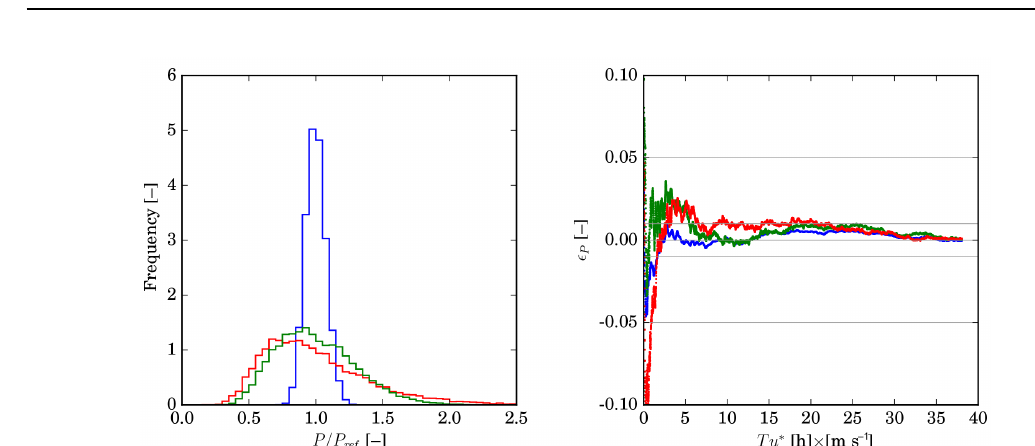
Figure 2. Convergence analysis of wind-farm and turbine power of an aligned wind-farm case (Case 4 in Table 2). (a) Probability density function of wind-farm power output and power output of a front-row and back-row turbine. (b) Convergence error (cid:15) P as a function of averaging time T for the wind-farm power, and for the power of a front-row and back-row turbine. Blue line: wind-farm power; green line: first-row turbine; red line: last-row